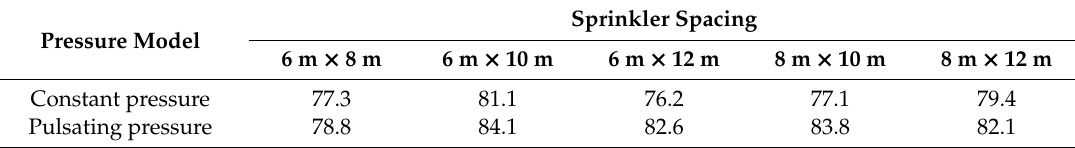
Table 2. Values of CU for constant and pulsating pressures with various sprinkler spacings, unit: %.